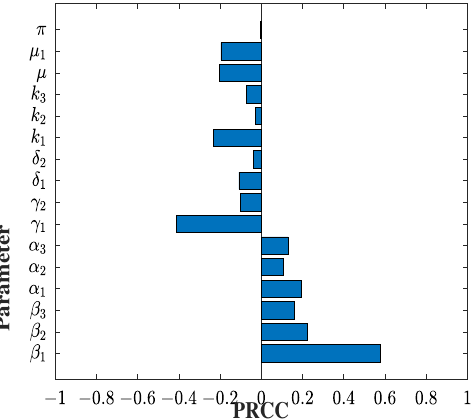
Fig. 5: A diagram showing the sensitivity of R model